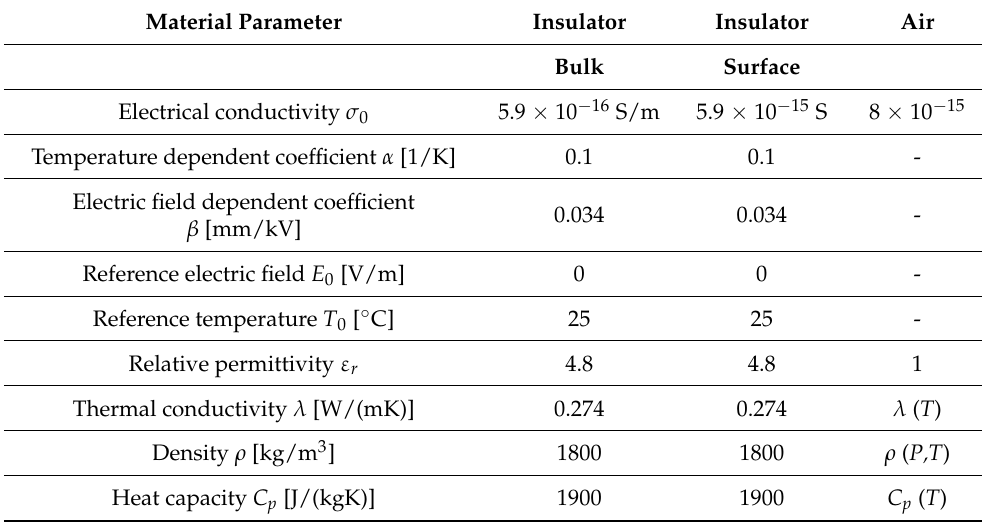
Table 1. Parameter of the insulator and air for the reference